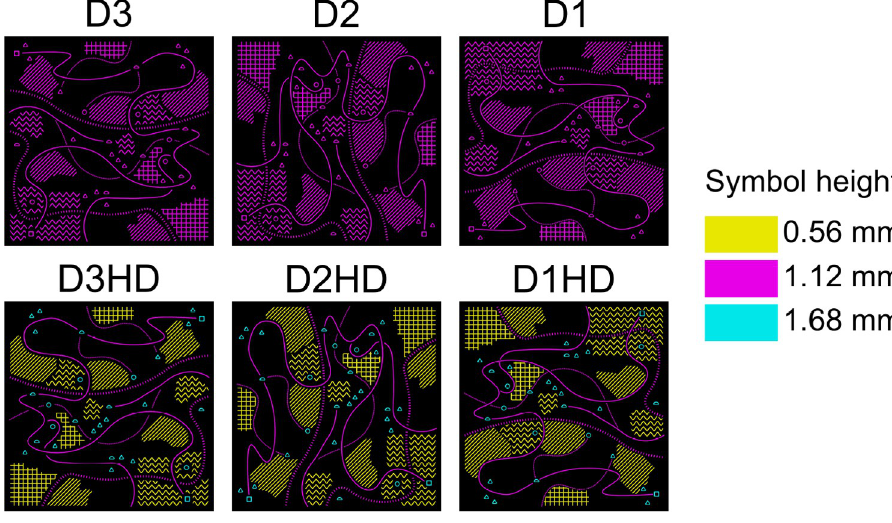
Fig 2. The stimuli used in our study. Different colours indicate heights of particular symbol types. Mirroring and rotations are visible.